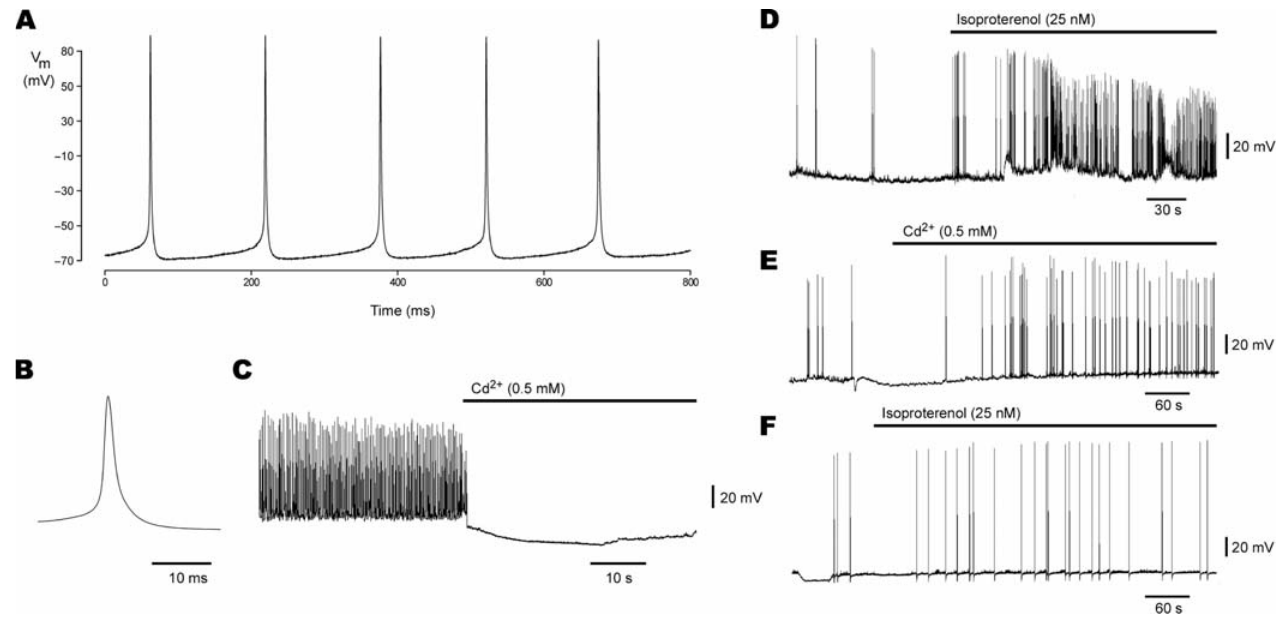
Figure 6. Whole-Cell Voltage Recordings from Spoc Cell–Derived Cardiomyocytes (A) Spontaneous AP firing in a nonbeating, teardrop-shaped cell. (B) Representative AP from recording in (A) on an expanded time scale; AP threshold is –60 mV. (C) Action potential firing in another cell is blocked upon bath perfusion with 0.5 mM cadmium chloride (horizontal bar). (D) Acceleration of AP firing upon perfusion with 25 nM isoproterenol (horizontal bar) is demonstrated, indicating the presence of adrenergic receptors on these cells. (E) Skeletal myotube APs, if present, differ in that their frequency is unaffected by Cd þþ . (F) Isoproterenol also does not affect skeletal muscle AP frequency. DOI: